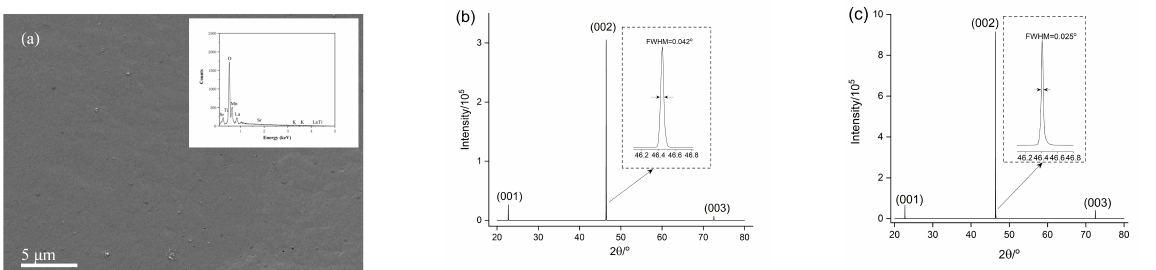
Figure 4. Characterization of the LaMnO 3 film on the SrTiO 3 substrate: ( a ) SEM image showing uniform and flat film surface. Inset: EDS spectrum; ( b ) symmetric ω /2 θ scan of the LaMnO3 film. Inset: FWHM of the LaMnO 3 film (002) peak; ( c ) symmetric ω /2 θ scan of the SrTiO 3 substrate. Inset: FWHM of the substrate (002) peak.